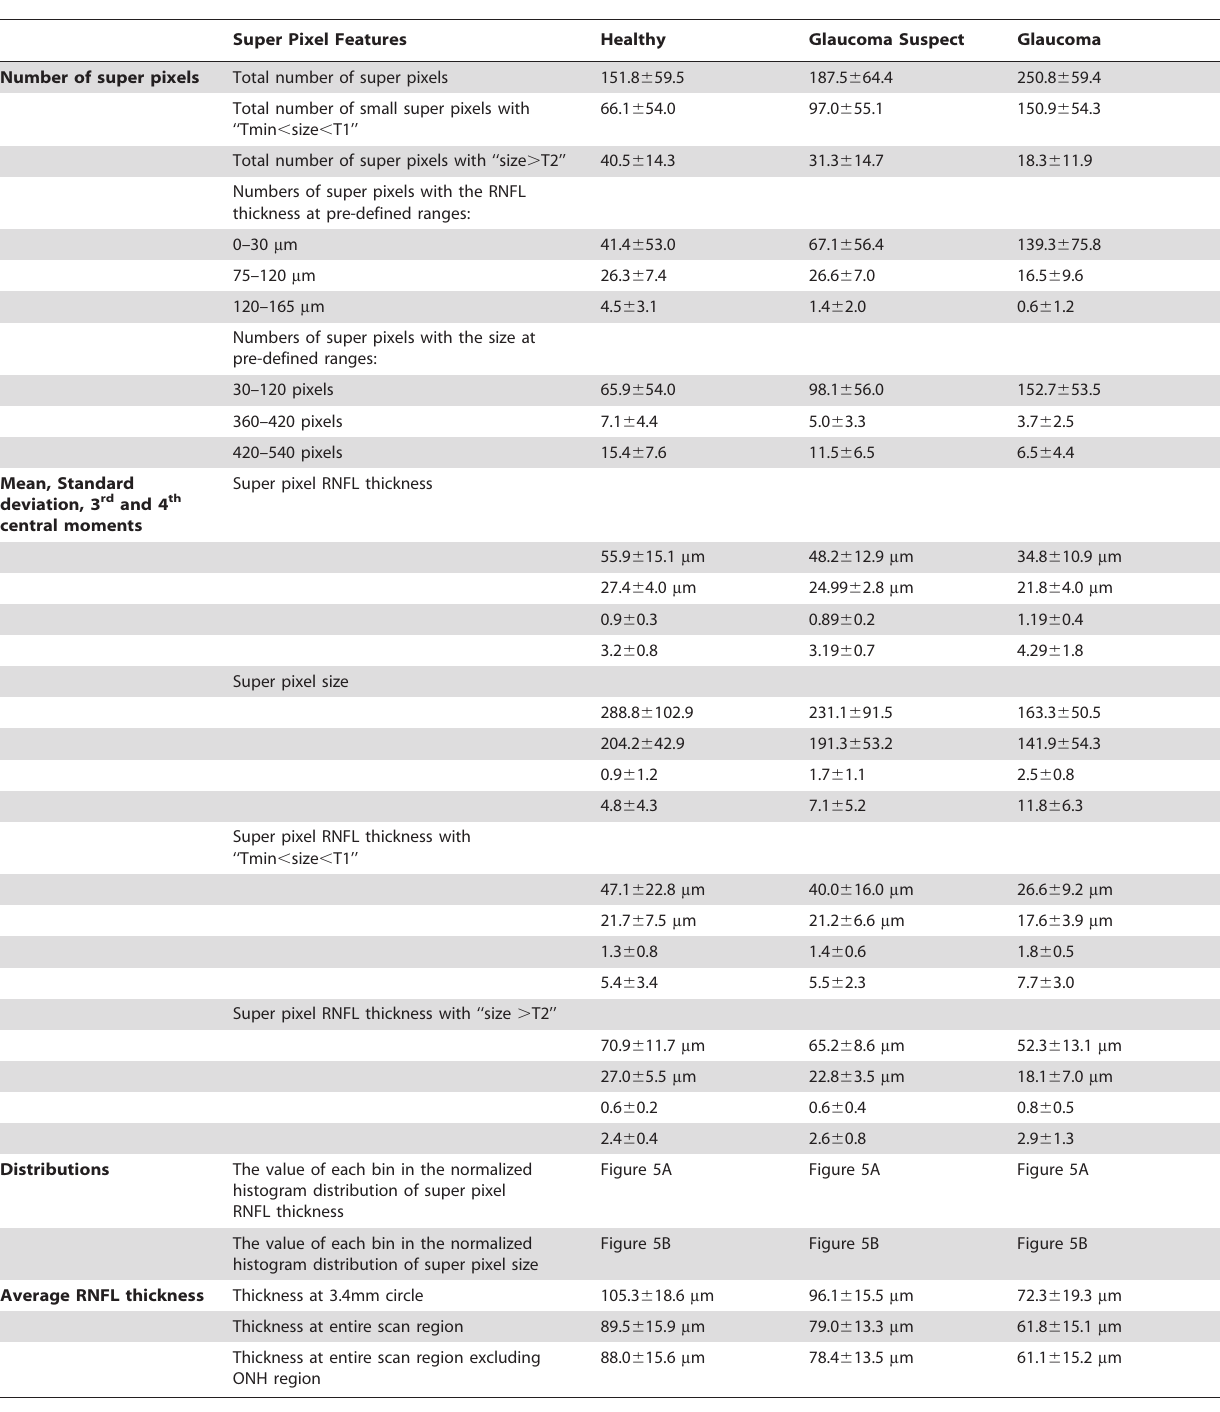
(200 6 200 6 1024 voxels) was converted to a 2D feature map